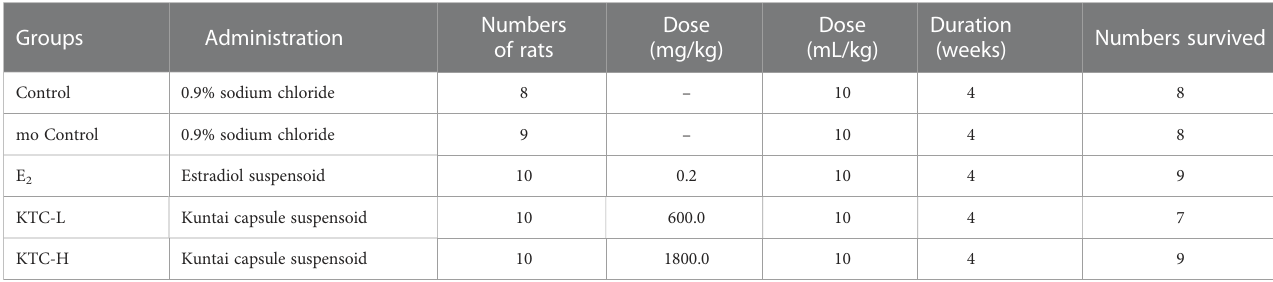
TABLE 1 Grouping, administration, and survival of the rats.